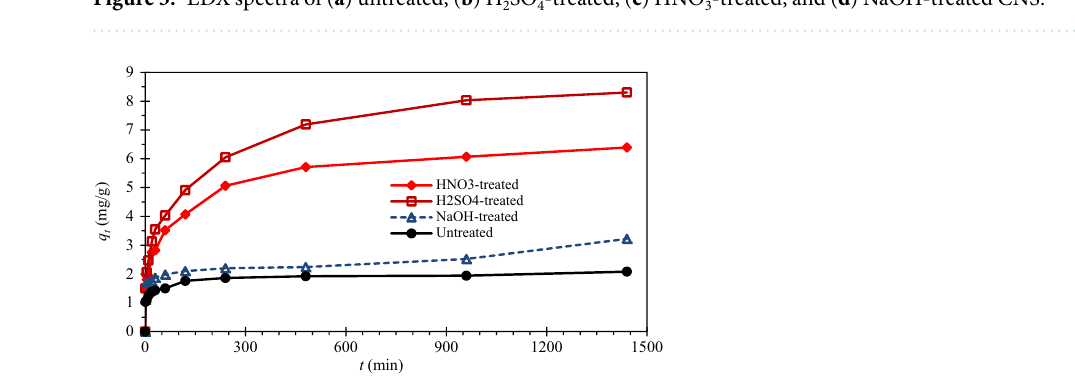
Figure 3. EDX spectra of ( a ) untreated; ( b ) H 2 SO 4 -treated; ( c ) HNO 3 -treated; and ( d ) NaOH-treated CNS.